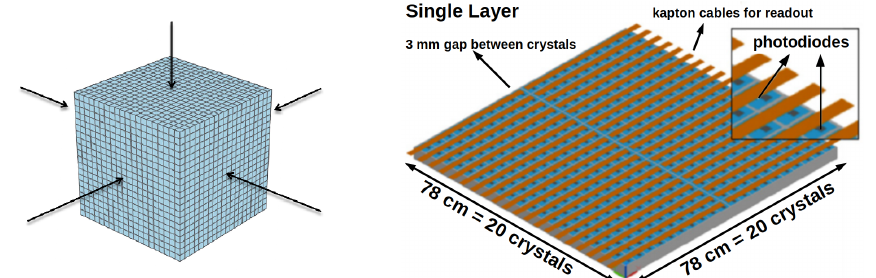
Figure 2. Conceptual design of the CaloCube 3D highly segmented calorimeter: on the left , the com- plete cubic detector; on the right , 1 of the 20 layers (from [8]).